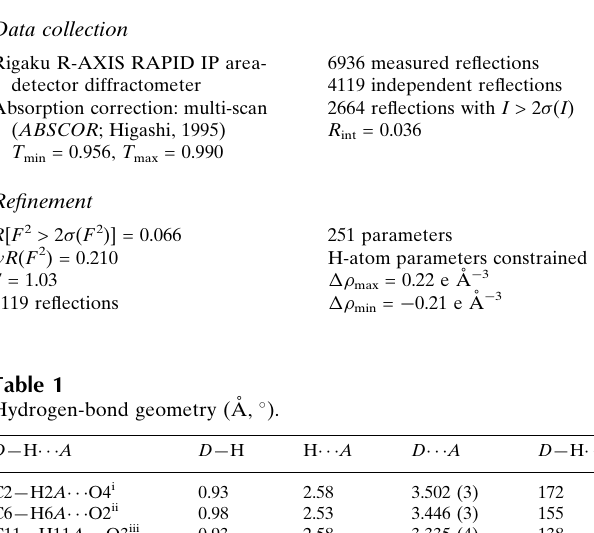
dihedral angle between the mean planes of the C—C